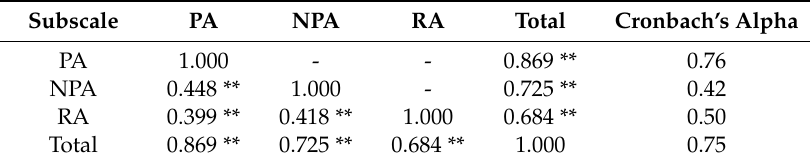
Table 2. Internal consistency reliability of each subscale and total